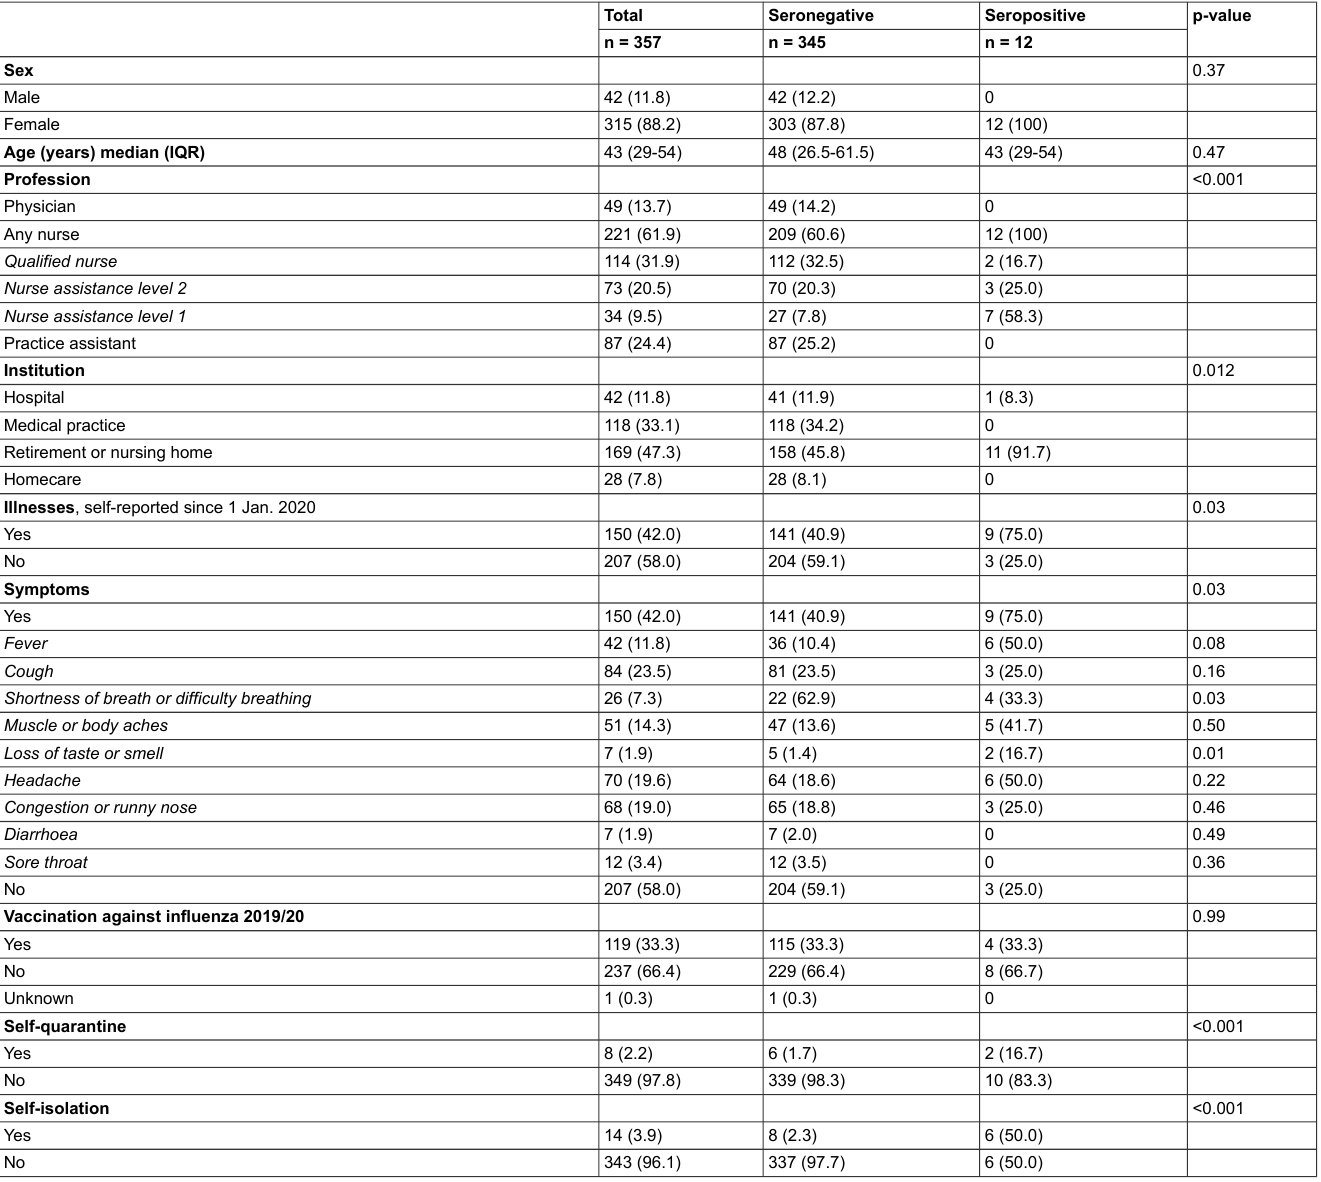
Table 2: Characteristics by serology